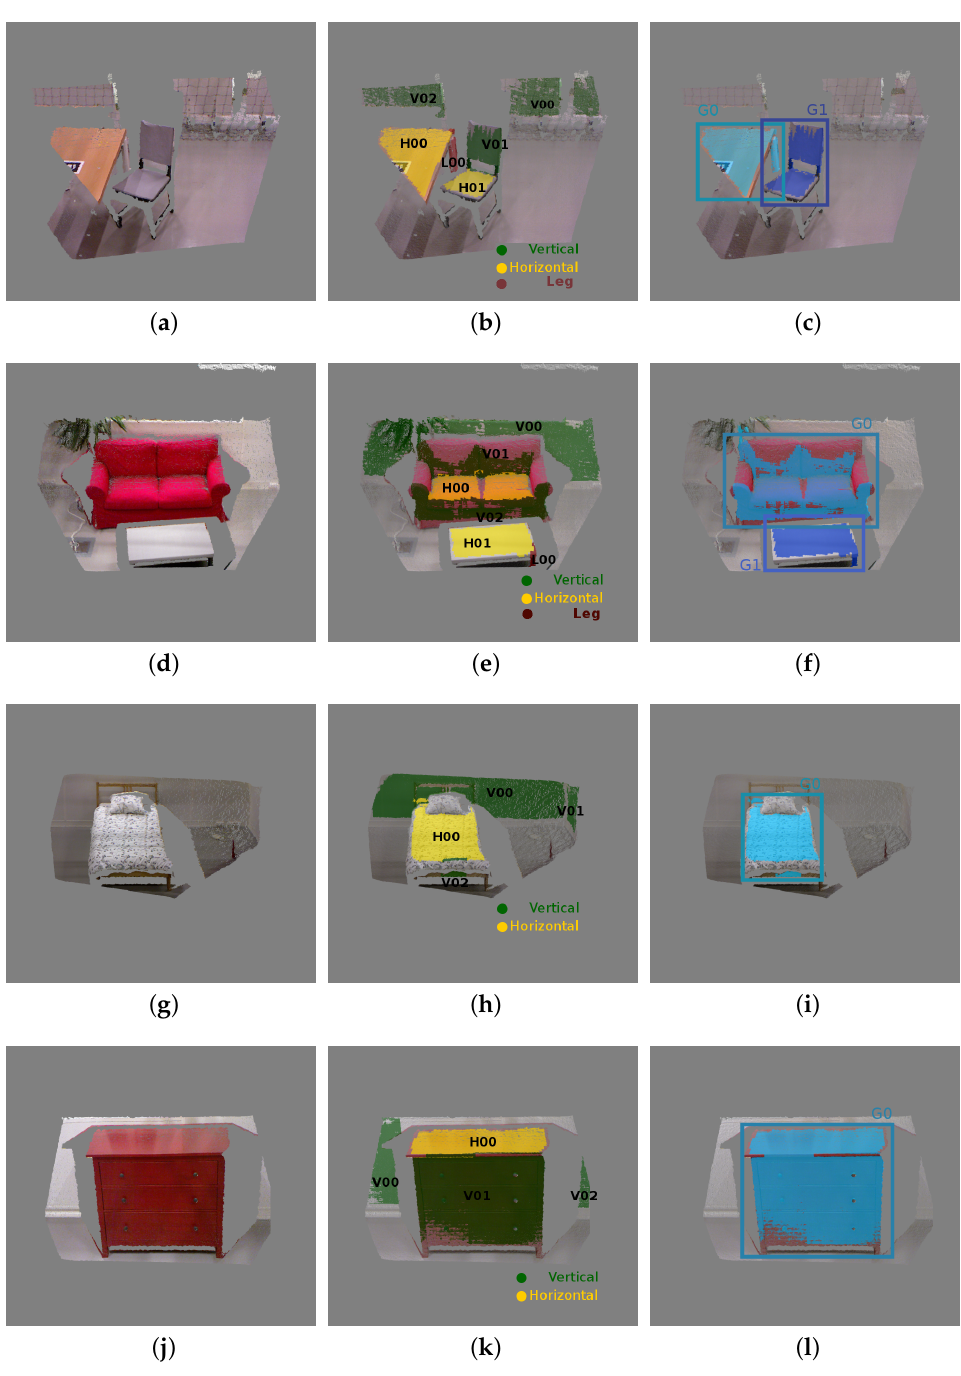
Figure 14. Results obtained for the furniture detection; each row shows the results for one scene. In ( a , d , g , j ), the original point clouds from the scenes. In ( b , e , h , k ) are shown the geometrical components found in the scene; the vertical planes are in green color, the horizontals in yellow and the legs in red. The bounding boxes in ( c , f , i , l ) show the graphs generated that were correctly identified as a piece of